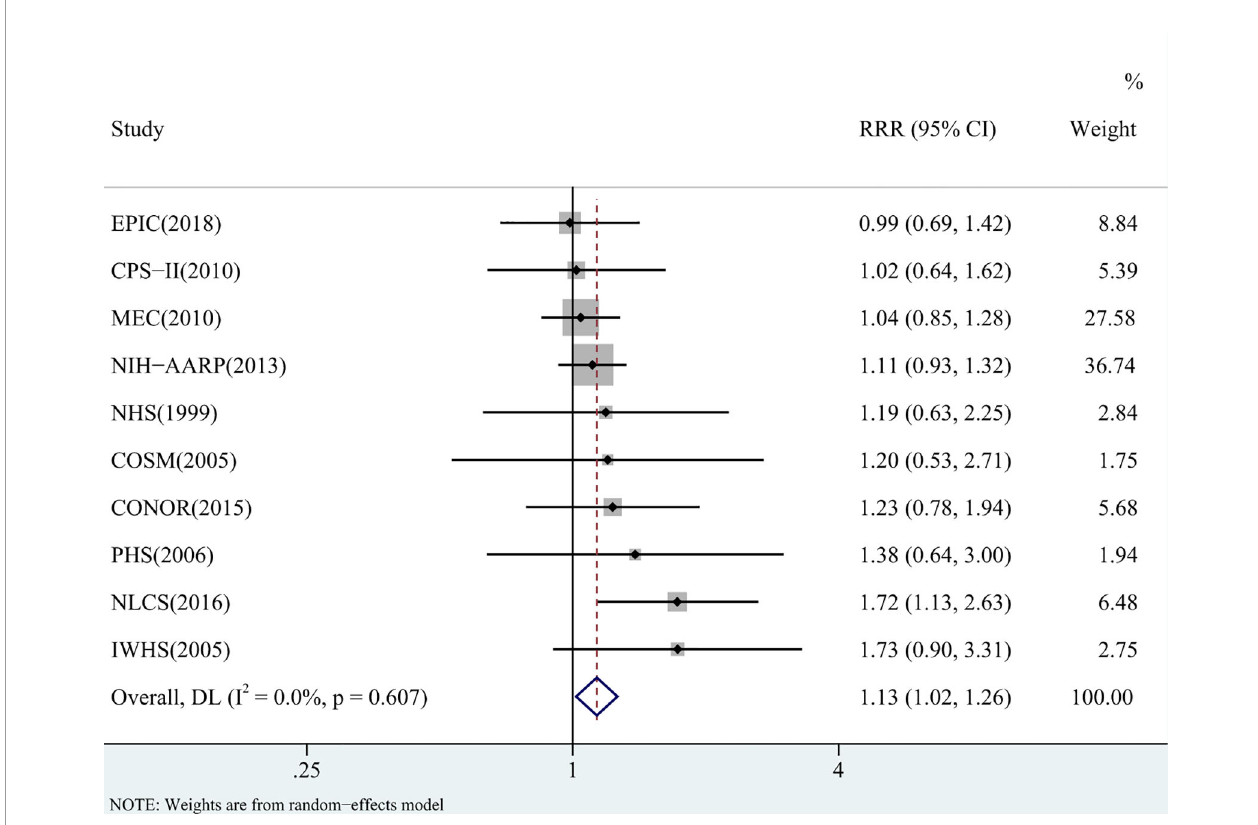
FIGURE 3 | Pooled RCC-to-LCC ratio of relative risks (RRRs) for comparing the association between diabetes and the risk of right-sided colon cancer (RCC) with that of left-sided colon cancer (LCC).